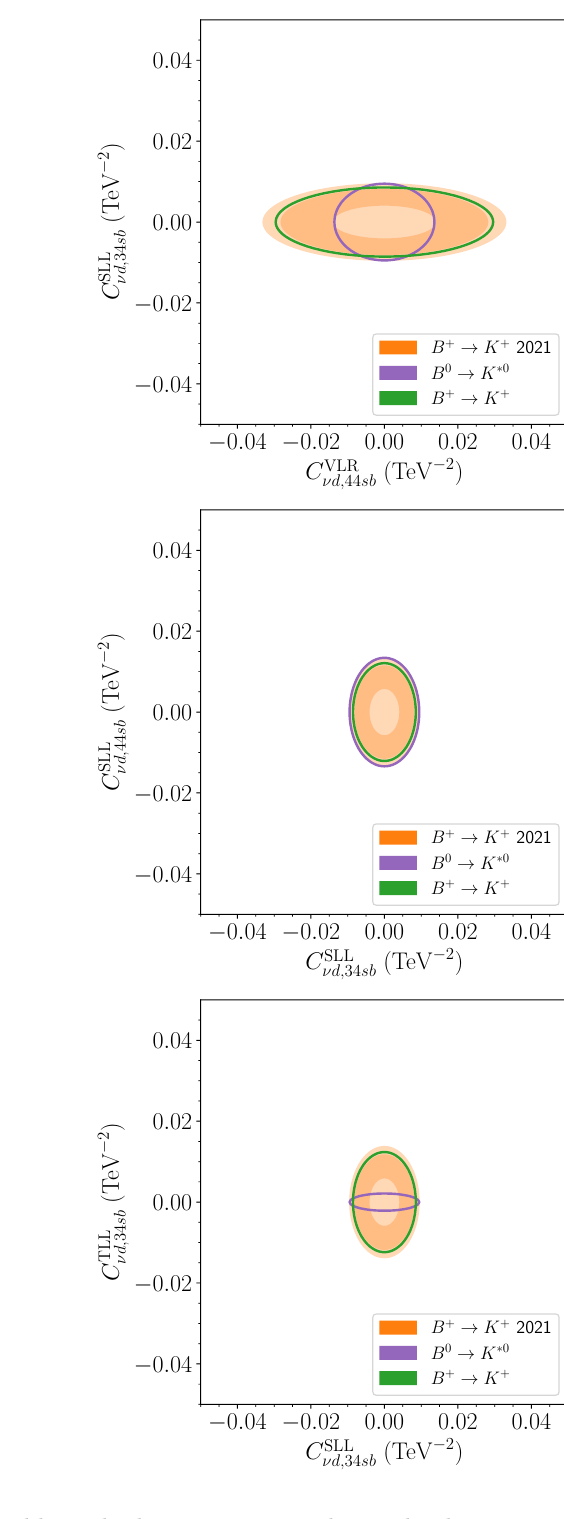
Figure 7 . Parameter space which is compatible with the non-zero simple weighted average of Br( B + → K + νν ) [4, 8] at 1 σ ( 2 σ ) [darker(lighter)-orange shaded region] and the current bounds on B + → K + νν and B 0 → K ∗ 0 νν